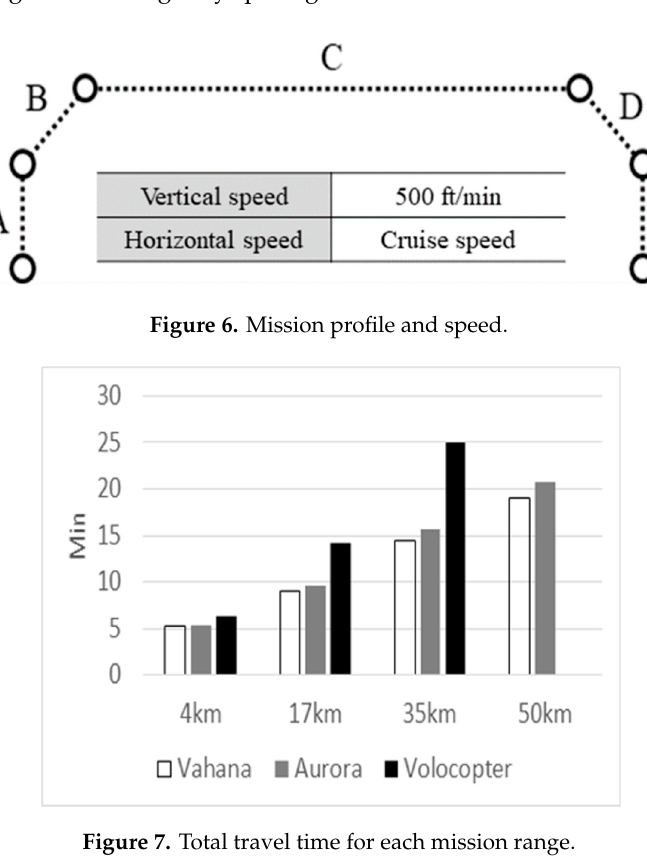
Figure 7. Total travel time for each mission range.